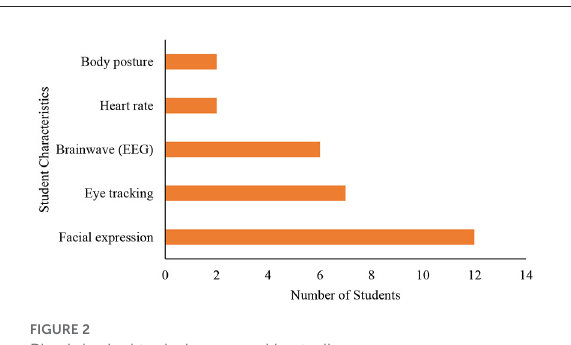
FIGURE2 Physiological techniques used in studies.